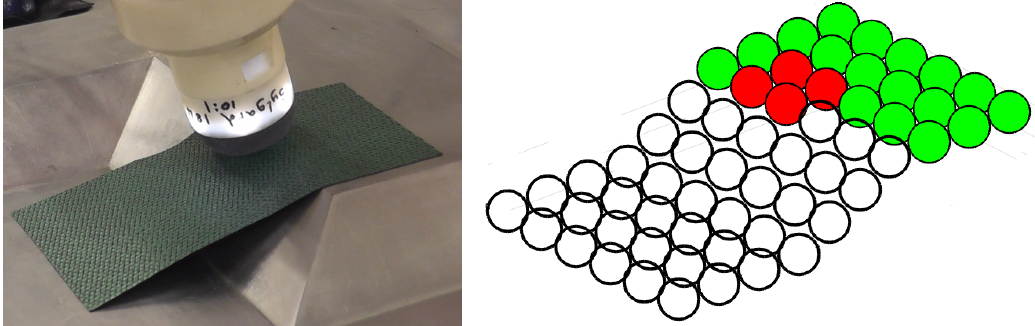
Figure 5: (Left) Image of the TacTip being applied to a layup while (Right) Real time data is displayed to the user via a Matlab scatter plot. Green = Correct, Red = Defect found.